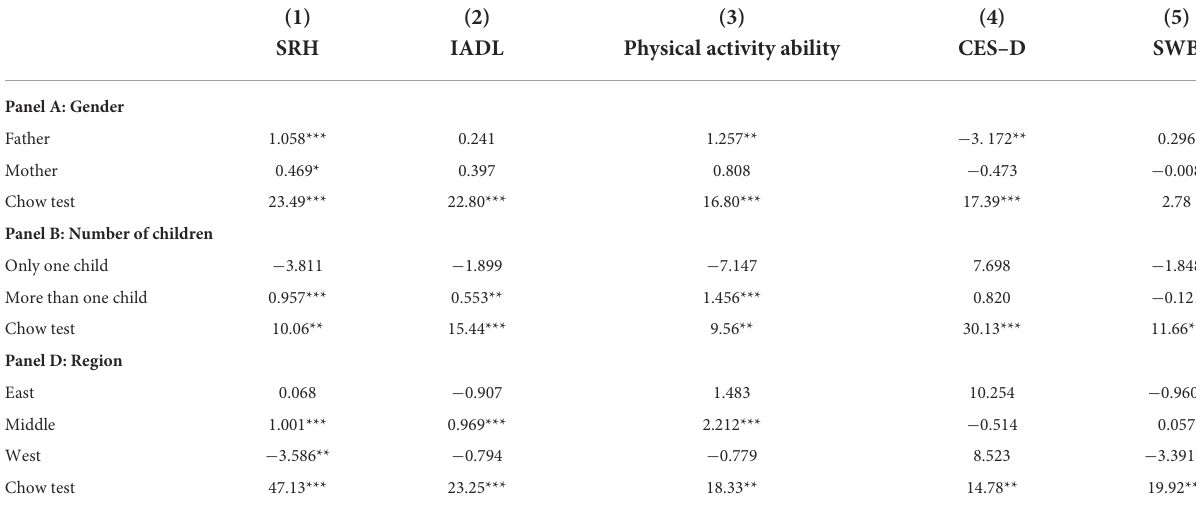
TABLE 4 Heterogeneity analysis results by